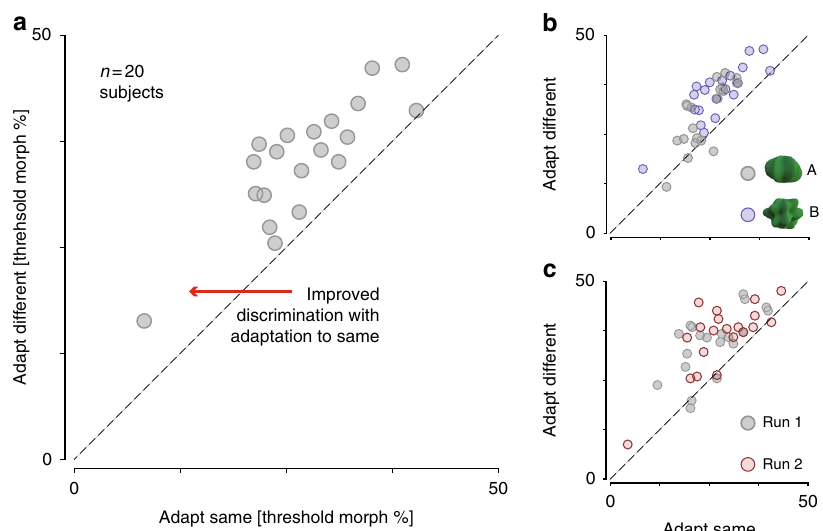
Fig. 2 Perceptual shape discriminability. a Shape discrimination thresholds are plotted for each subject ( n = 20) after adapting and testing for the same shape class ( x -axis) vs. adapting and testing to different shape classes ( y -axis). Each data point is the average over two repetitions and over both prototype shapes. All data points lie above the diagonal, indicating that shape discrimination thresholds were lower after adapting to the same shape class for every subject. b Thresholds shown separately for the two prototype shapes, averaged over runs. The two distributions are partially non-overlapping, suggesting that shape class A was easier to discriminate overall than shape class B. c Thresholds shown separately for the two runs, averaged over